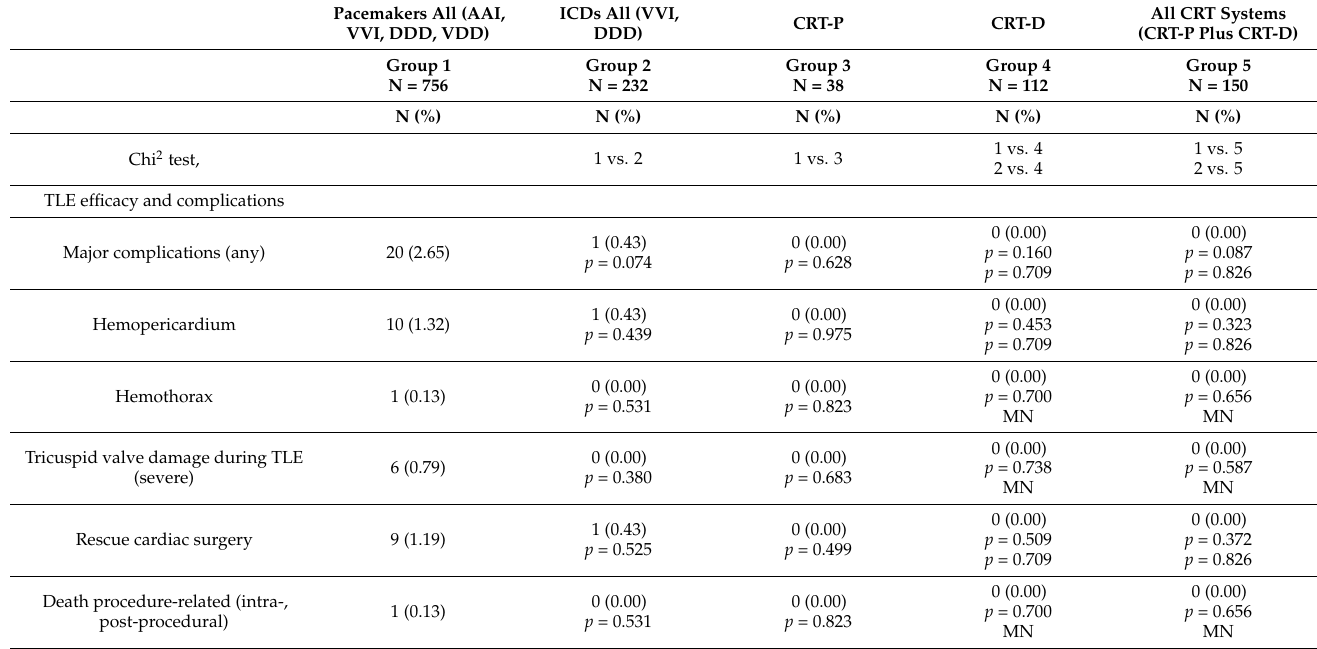
Table 5. TLE efficacy and complications in compared groups of patients with different CIED